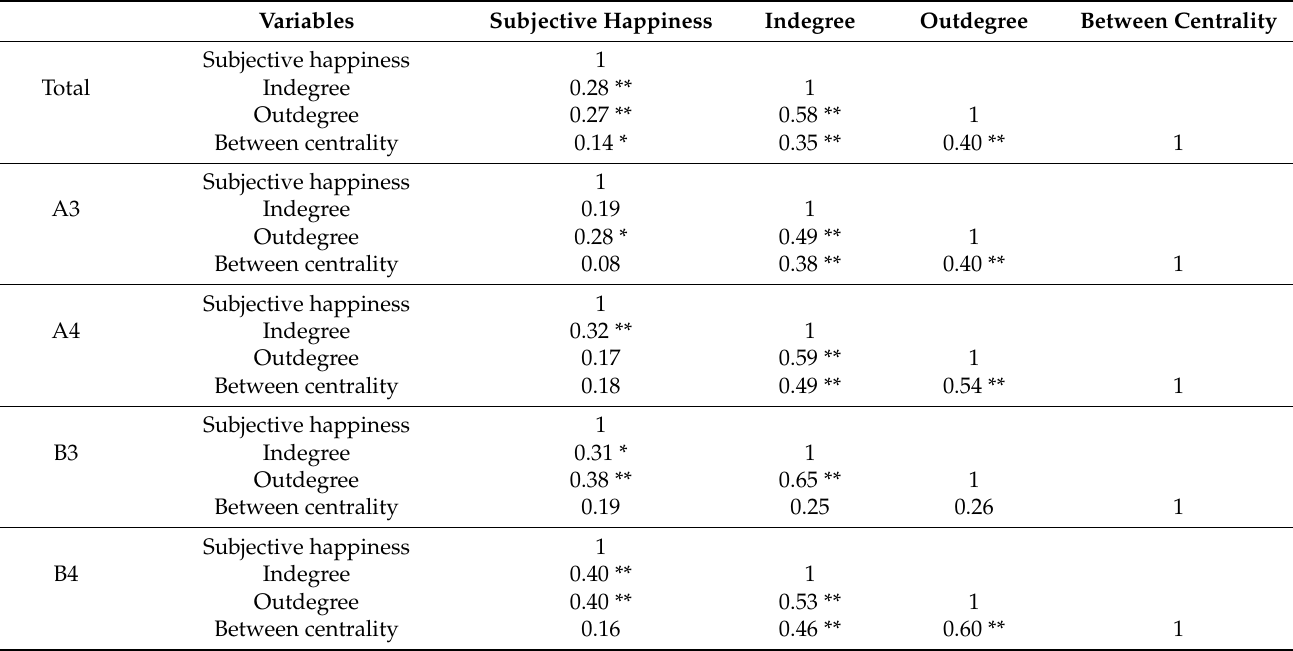
Table 2. Correlations between the research